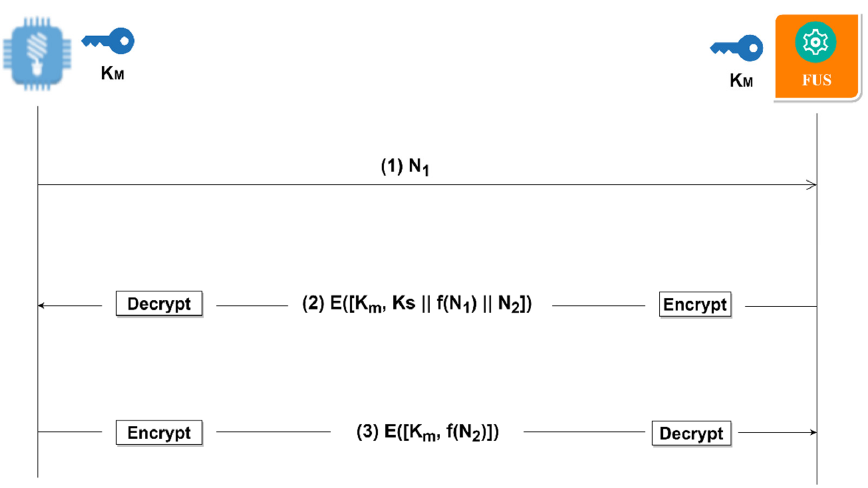
Figure 7. Session Key Exchange.